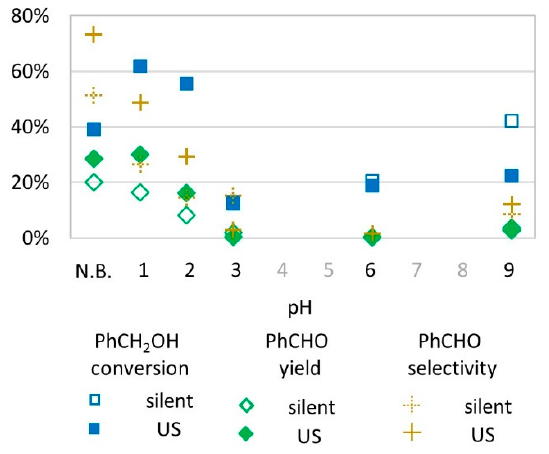
Figure 4. Oxidation of PhCH 2 OH as a function of pH (bu ff ered or not) in silent condition and under US irradiation (20 kHz). Reaction conditions: 571 mM PhCH 2 OH, 1 molar eq. H 2 O 2 ; 1% molar eq. FeSO 4 , 5.61 mL H 2 O, 70 ◦ C, 15 min. In non-bu ff ered (N.B.) conditions and at pH 1, 2, and 3, empty blue square and full blue square overlap.